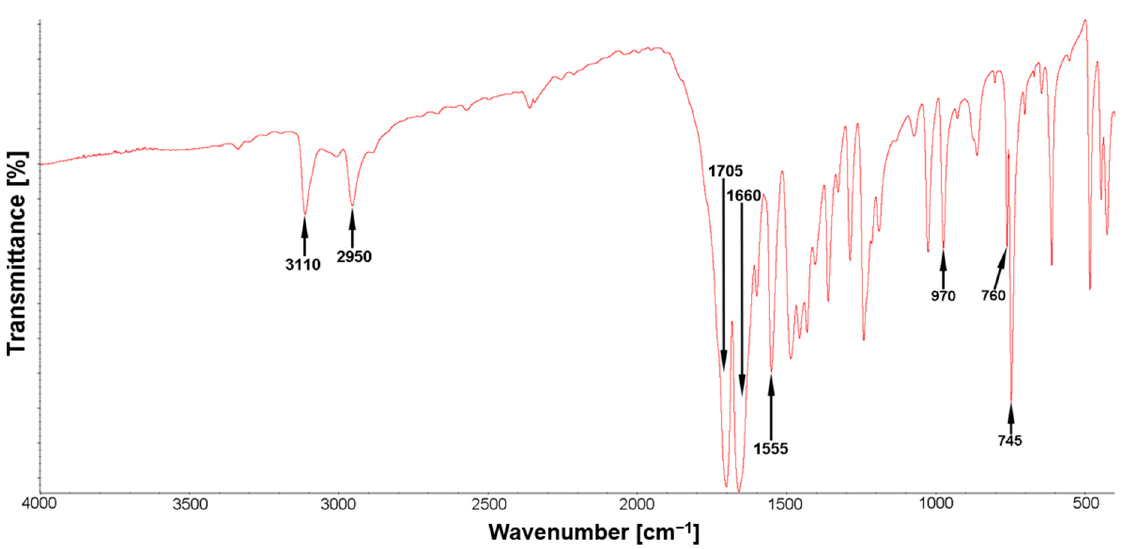
Figure A1. Fourier transform infrared (FTIR) spectra of pure caffeine at the 4000 to 400 cm − 1 range .